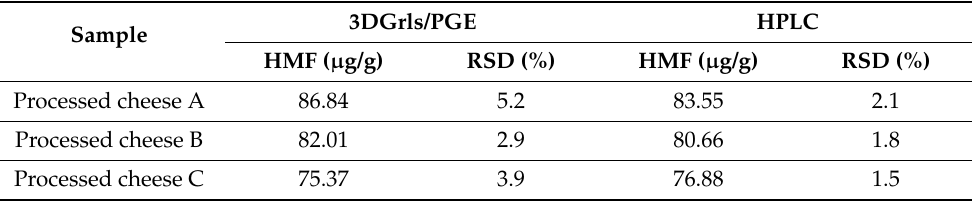
Table 2. Determination of HMF in real samples with the 3DGrls/PGE ( n =